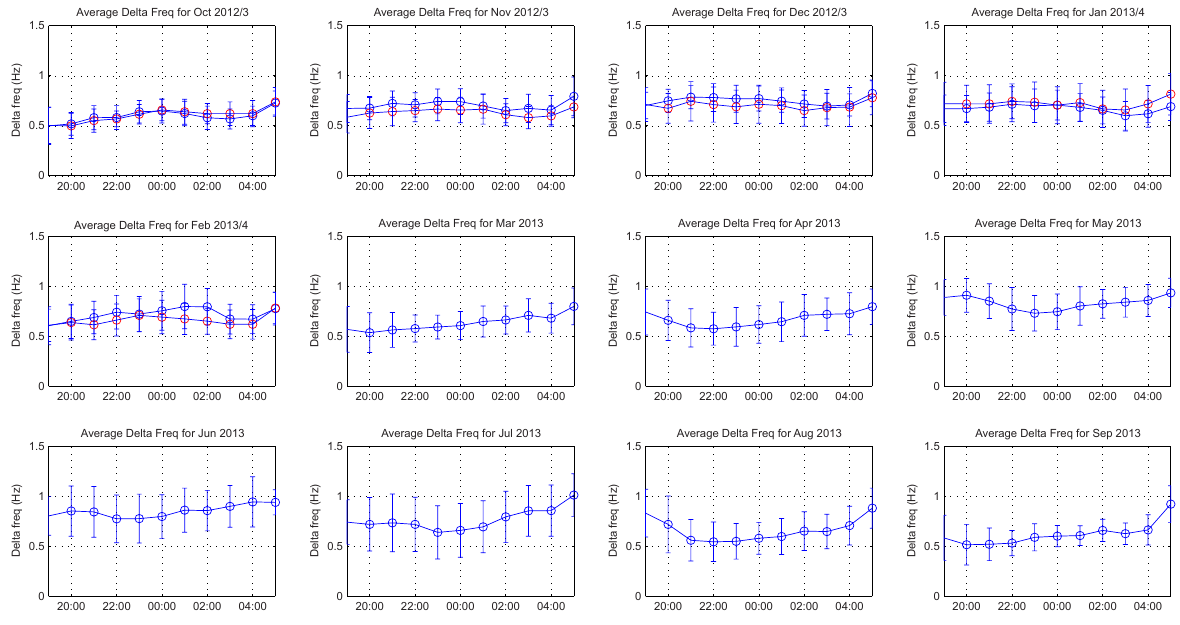
Figure 5. Plots of the hourly mean value of 1f across each month for all 525 days from October 2012 to February 2014. Data for Octo- ber 2012–September 2013 (blue) and October 2013–February 2014 (red). Error bars show 1 σ -level